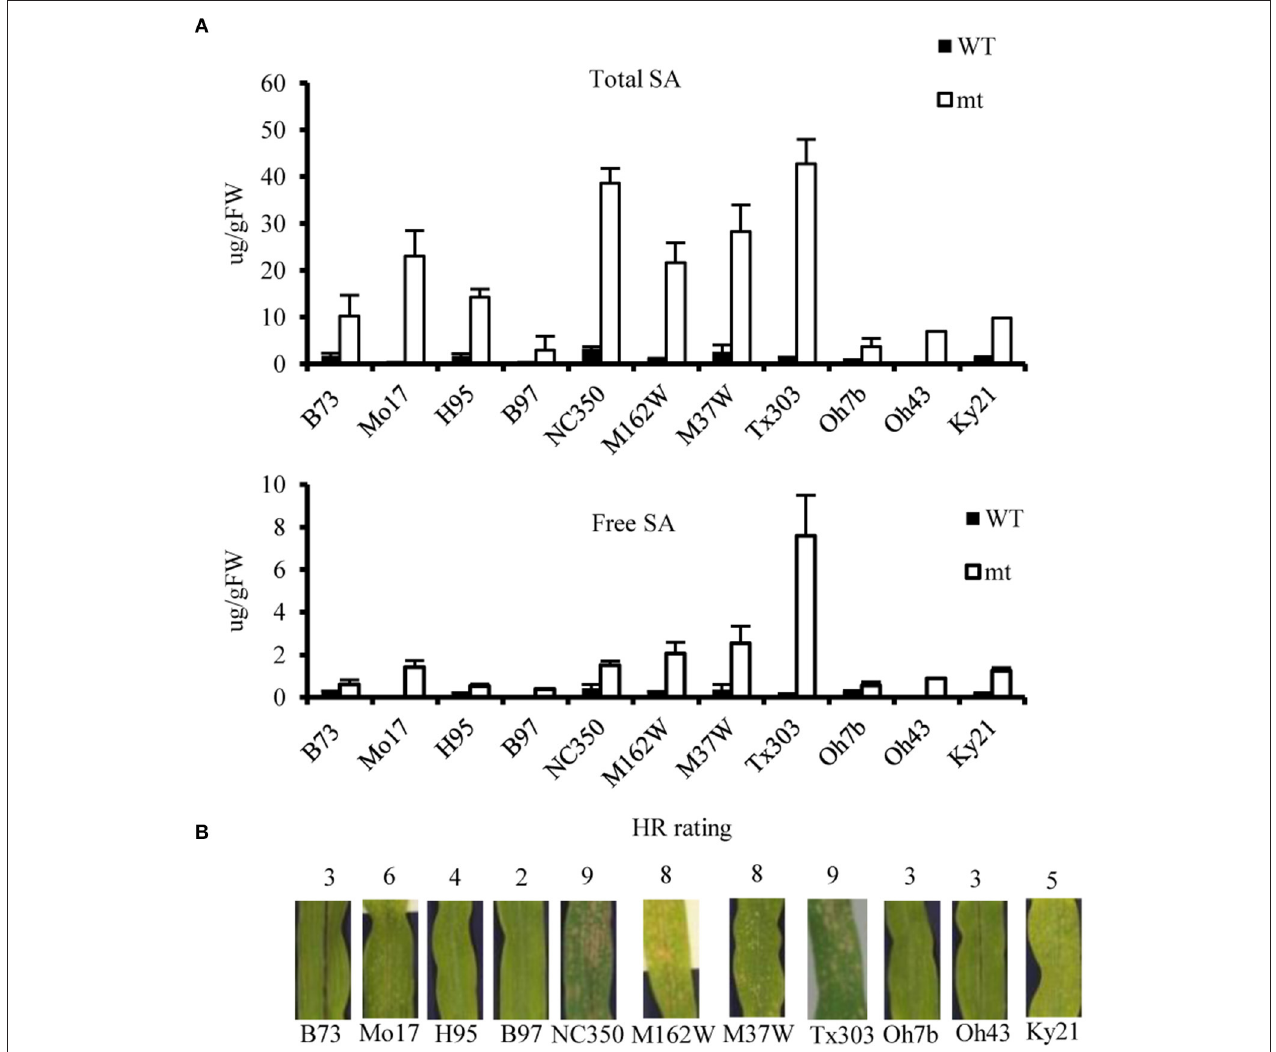
FIGURE 5 | The salicylic acid (SA) levels and hypersensitive response (HR) severity of Rp1-D21 in different genetic backgrounds. (A) The levels of total SA and free SA were significantly accumulated in Rp1-D21 mutant (mt) compared to the wild type (WT) in different backgrounds crossed with H95- Rp1-D21 when they were grown at 22 ◦ C. (B) The HR rating of Rp1-D21 mt in different backgrounds crossed with H95- Rp1-D21 grown at 22 ◦ C